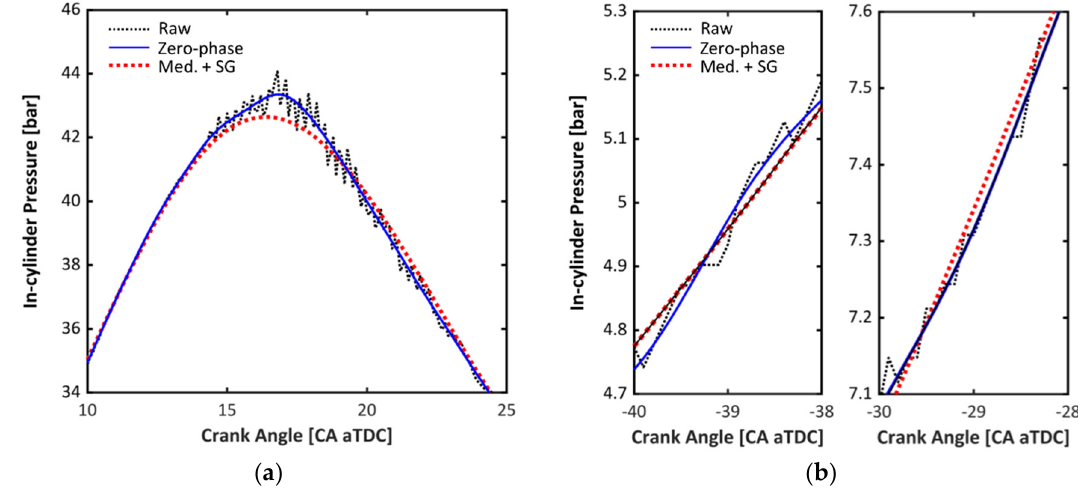
Figure 8. Post-processing of in-cylinder pressure signal: ( a ) zero-phase filtering in high-pressure region; ( b ) signal merging